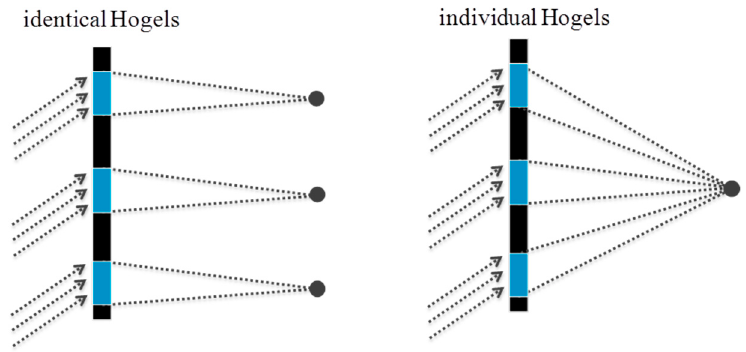
Figure 20. ( left ) A vHOE stitched with identical Hogels. The same function at a different position is reconstructed. ( right ) A vHOE stitched with individual Hogels. Each Hogel is corrected with respect to its position on the vHOE, so that a single focal point is reconstructed [57].